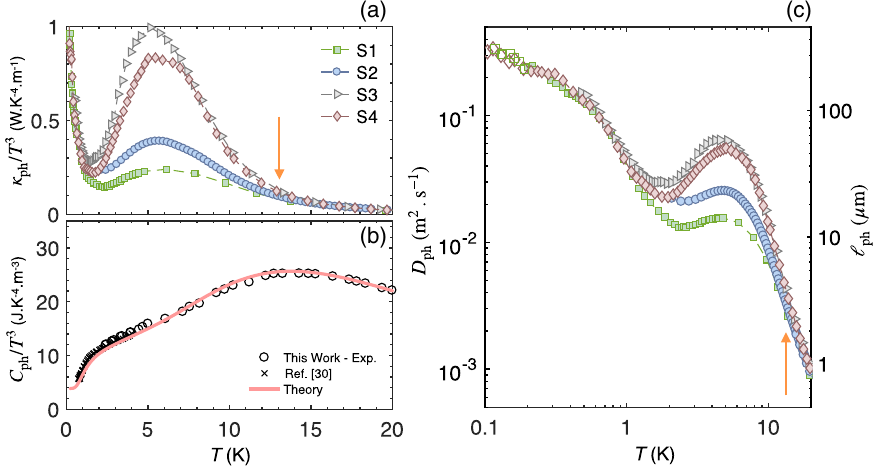
FIG. 2. Thermal conductivity, heat capacity, and thermal diffusivity of phonons. (a) Phononic thermal conductivity κ =T 3 as a function of the temperature. (b) The phononic specific heat C κ ph line represents ab initio calculations. (c) The lattice thermal diffusivity D temperature. Note the emergence of a size-dependent peak and a minimum in the T ¼ 2 – 15 K temperature range. Orange arrows indicate the temperature below which D